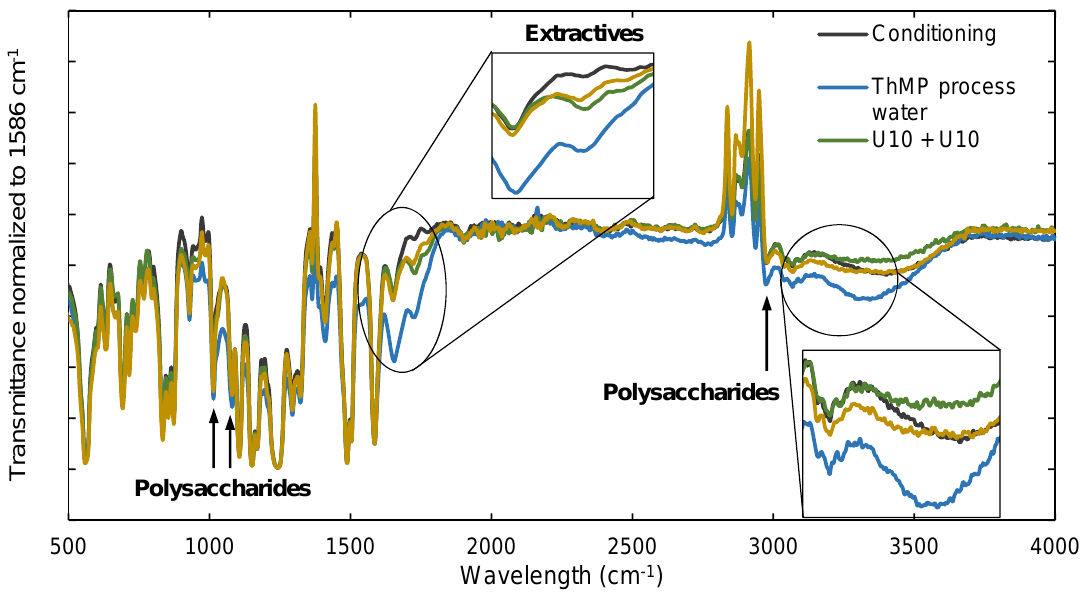
Figure 3. ATR-FTIR spectra of membrane samples after conditioning (gray), filtration of ThMP process water (blue line), two-step alkaline cleaning with Ultrasil 10 (U10 + U10, green), and two-step enzymatic cleaning with the enzyme cocktail followed by Ultrasil 10 (EC + U10, brown). The transmittance was normalized to the intensity of the transmittance peak at 1586 cm − 1 .